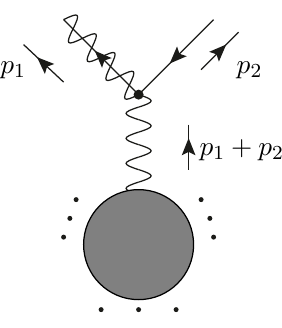
Figure 8 . Feynman diagrams leading to soft gravitino